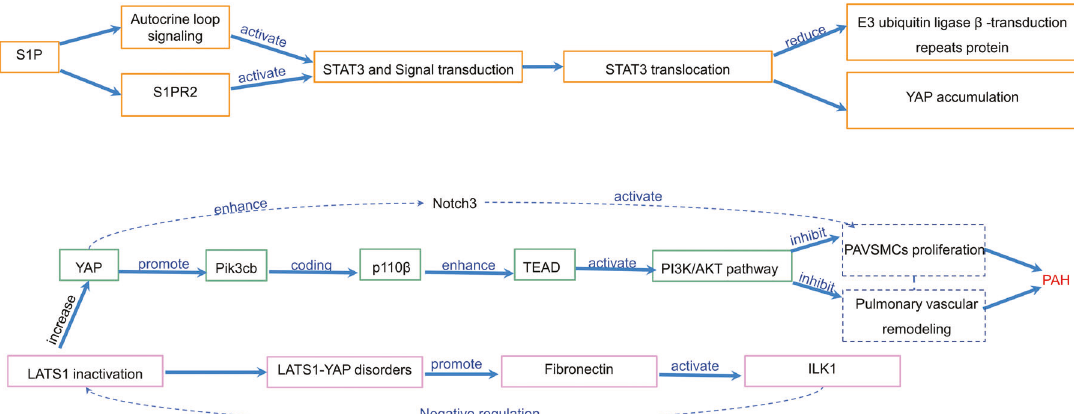
Fig. 3 The role of hippo signaling pathway in PAH. Inactivation of LATS1 enhanced the activity of YAP. YAP promotes the transcription of Pik3cb, which encodes the catalytic subunit P110 β of PI3K and enhances TEAD, thereby activating the PI3K/AKT pathway. PI3K/AKT pathway promotes PAVSMCs proliferation and pulmonary vascular remodeling and aggravates PAH. In addition, inactivation of LATS1 leads to LATS1- YAP dysregulation, which promotes the production of fi bronectin and activates ILK1. Inhibition of ILK reactivating LATS1 in PAVSMCs leads to downregulation of YAP, inhibition of PAVSMCs proliferation, and induction of apoptosis. In addition, S1P promotes the activation of STAT3 through S1PR2 or autocrine loop signaling, which further lead to STAT3 translocates to the nucleus [97, 108]. STAT3 translocation further reduces the expression of E3 ubiquitin ligase β -transduction repeat protein and inhibits degradation of YAP ubiquitination in PAVSMCs. Note: PAH pulmonary arterial hypertension, LATS1/2 large tumor suppressor 1/2, TEAD TEA domain family, S1P sphingosine-1-phosphate, PAVSMCs pulmonary arterial vascular smooth muscle cells, S1PR2 sphingosine-1-phosphate receptor 2, ILK1 integrin-linked kinase 1, PI3K phosphatidylinositol